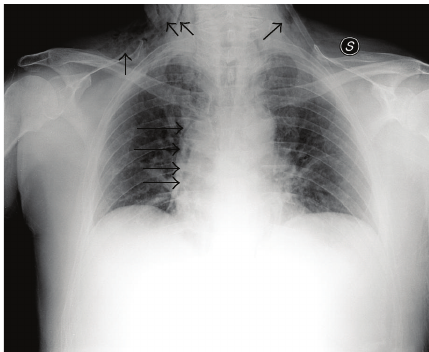
Figure 2: Chest X-ray showed subcutaneous emphysema, with gas tracking into the neck area bilaterally and a paracardiac gas stripe of the right (black